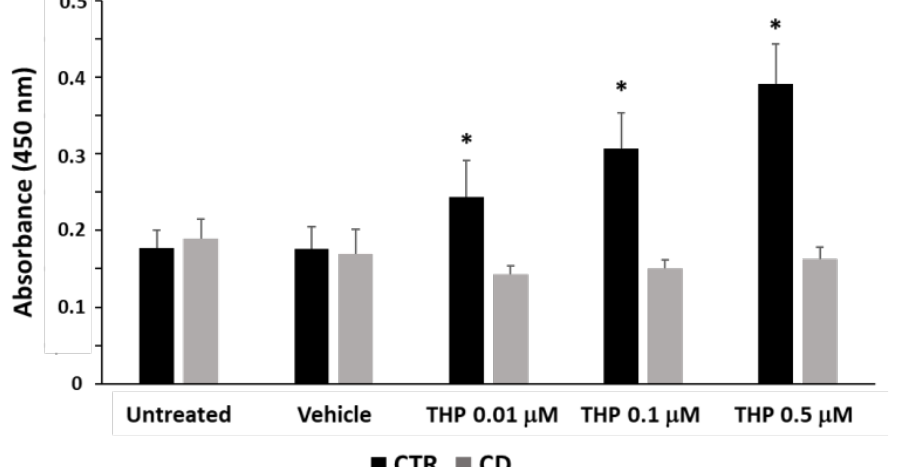
Figure 10. Enzymatic activity of intracellular TG2 expressed as absorbance at 450 nm in skin-derived fibroblasts from three controls and three CD subjects. Data are reported as mean ± SE. * p < 0.05 versus respective untreated samples.